Question: Provide a one-line summary of what is displayed.
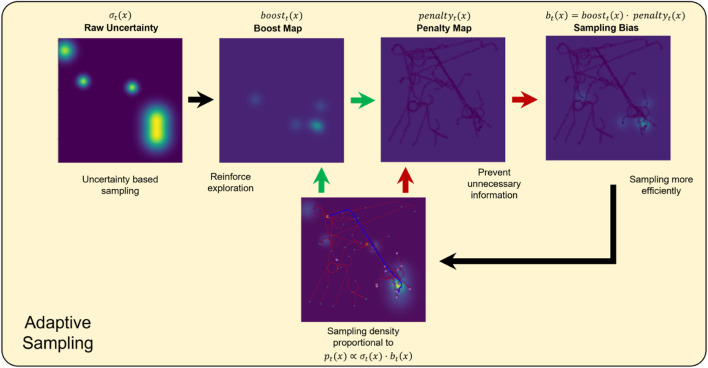
Answer: Adaptive uncertainty-guided sampling. The predictive variance σ t 2 ( x ) defines the baseline sampling density. Boosting reinforces sampling near high-information nodes, while penalization suppresses sampling along previously traversed paths. The combined bias b t ( x ) = b o o s t t ( x ) ⋅ p e n a l t y t ( x ) reshapes the sampling distribution as p t ( x ) ∝ σ t 2 ( x ) ⋅ b t ( x ) , promoting efficient and non-redundant exploration.